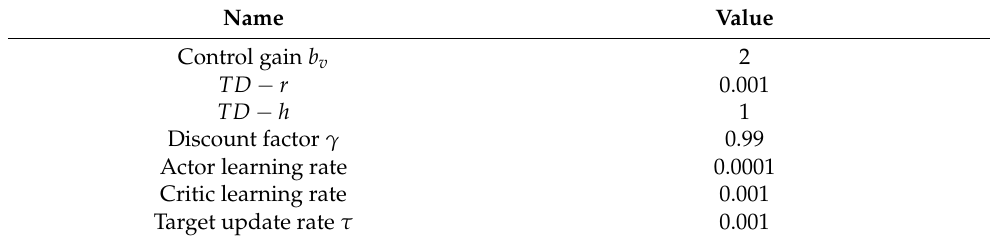
Table 7. Parameters of TD3-LADRC.